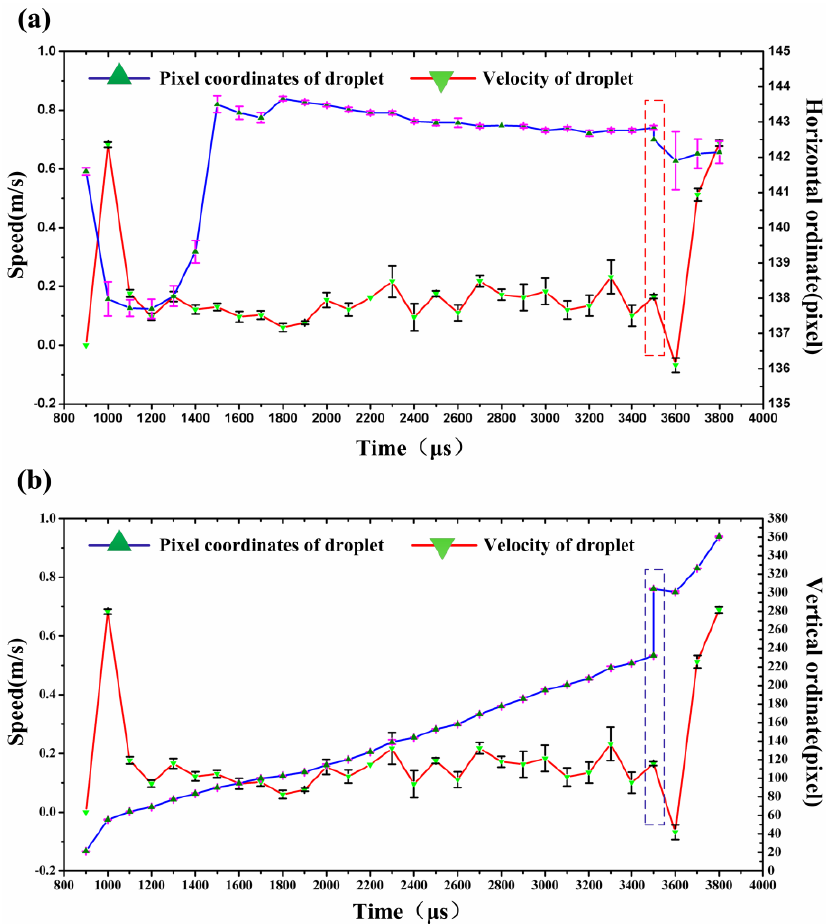
Figure 16. The speed and ordinate of the microdroplet at different times. ( a ) speed and horizontal ordinate VS time, ( b ) speed and vertical ordinate VS time.